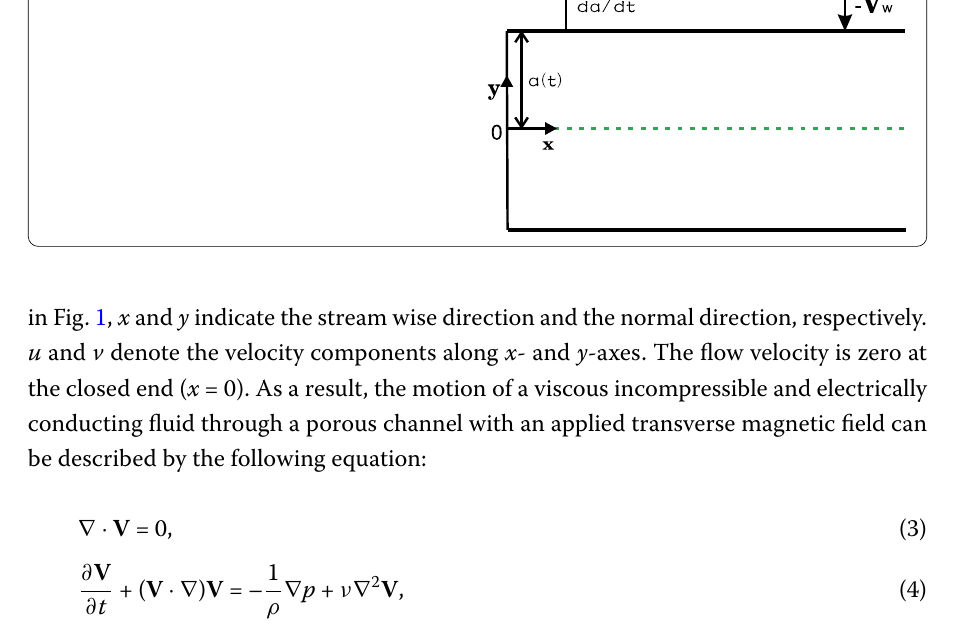
Figure 1 Physical